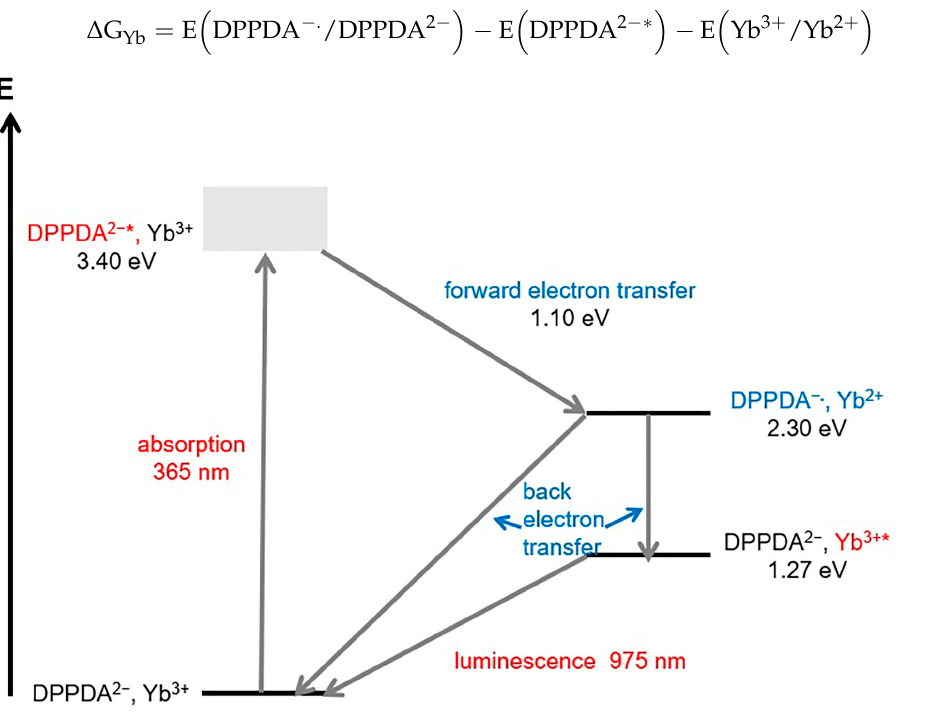
Figure 6. Schematic representation of internal redox mechanism of [Yb(DPPDA) 2 ](DIPEA).